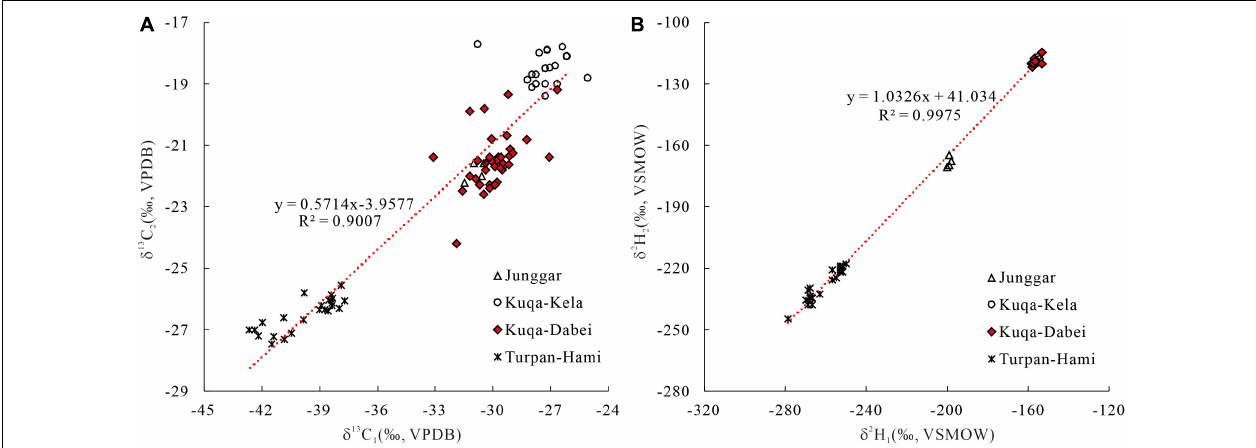
FIGURE 13 | Plots of δ 13 C 1 vs. δ 13 C 2 (A) and δ 2 H 1 vs. δ 2 H 2 (B) of gases from Dabei and Kela2 gas fields in the Kuqa depression in Tarim Basin, also from the Turpan-Harmi and Junggar basins in China. Gas data of Kela2 gas field were from Qin et al. (2007), gas data of the Turpan-Hami Basin were from Ni et al. (2015) and gas data of Junggar Basin were from Wang et al.